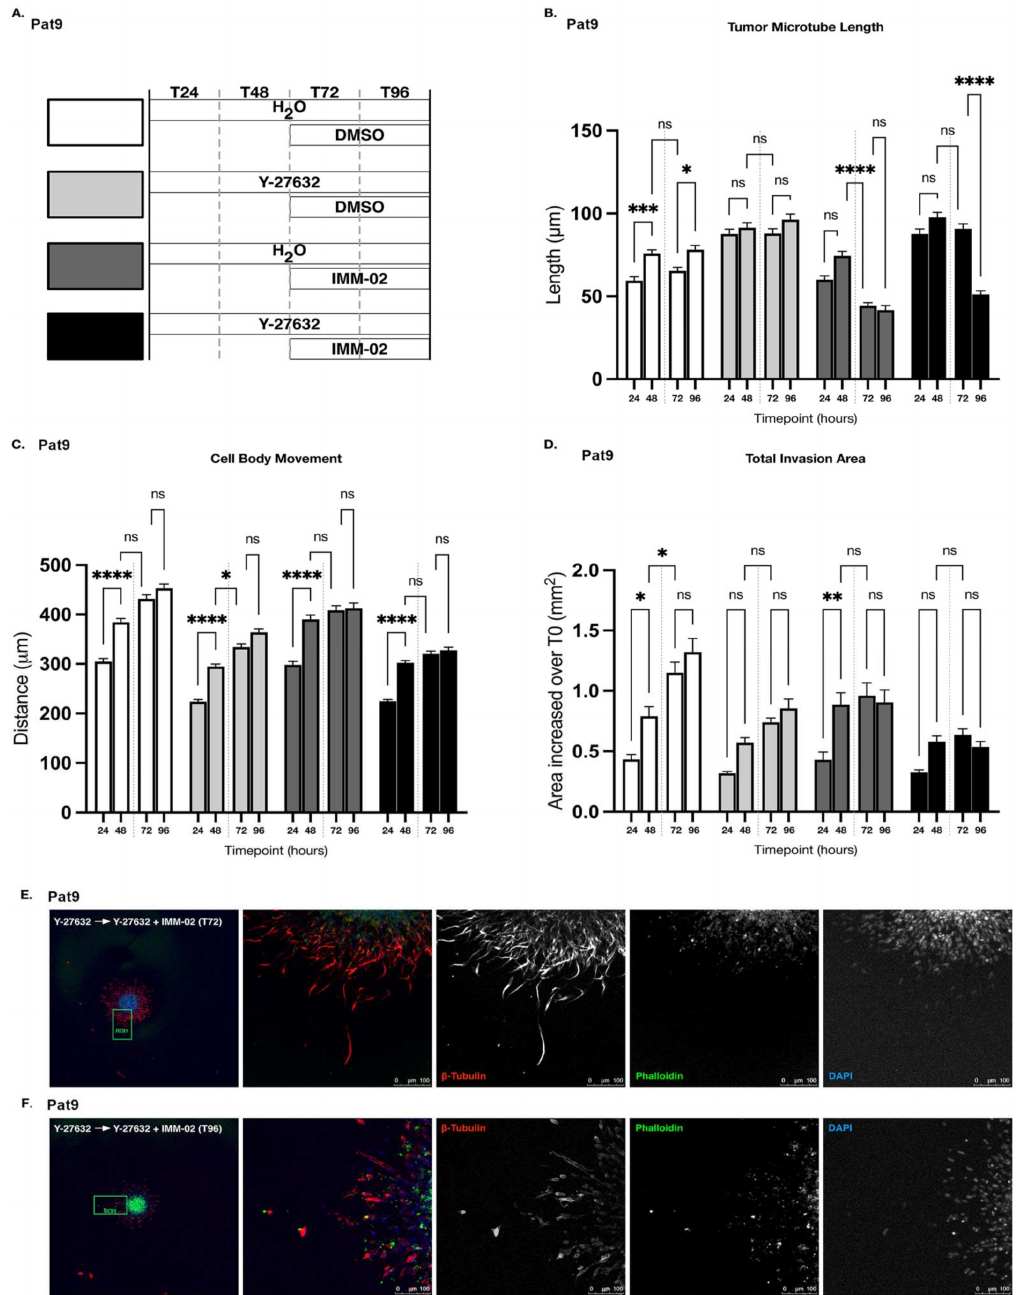
Figure 5. Sustained ROCKi postpones cellular responses to mDia agonists in invading GBM spheroids. ( A ) Schematic of drug exposures in add-drug 3D invasion assays (Y-27632 = 90 µ M; IMM-02 = 50 µ M). ( B ) Tumor microtubule length in indicated Pat9 96 h add-drug invasion assays. Dotted line shows time of drug addition. **** p ≤ 0.0001; *** p ≤ 0.001; * p ≤ 0.05; ns = not significant. ( C ) Distance of cell body movement from the sphere core in indicated Pat9 96 h add-drug invasion assays. Dotted line shows time of drug addition. **** p ≤ 0.0001; * p ≤ 0.05. ( D ) Increase in total invasion area over T0 in indicated Pat9 96 h add-drug 3D invasion assays. Dotted line shows time of drug addition. ** p ≤ 0.01; * p ≤ 0.05. ( E ) Confocal images of leading edge at T72 in Pat9 add-drug 3D